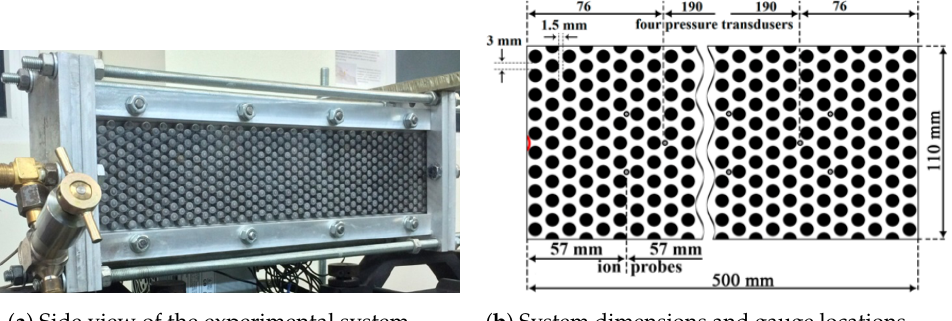
Figure 1. The experimental system showing: ( a ) the channel with cylindrical obstacles; and ( b ) the dimensions, sizes, and spacing of the cylindrical obstacles, as well as the locations of the ion probes and pressure